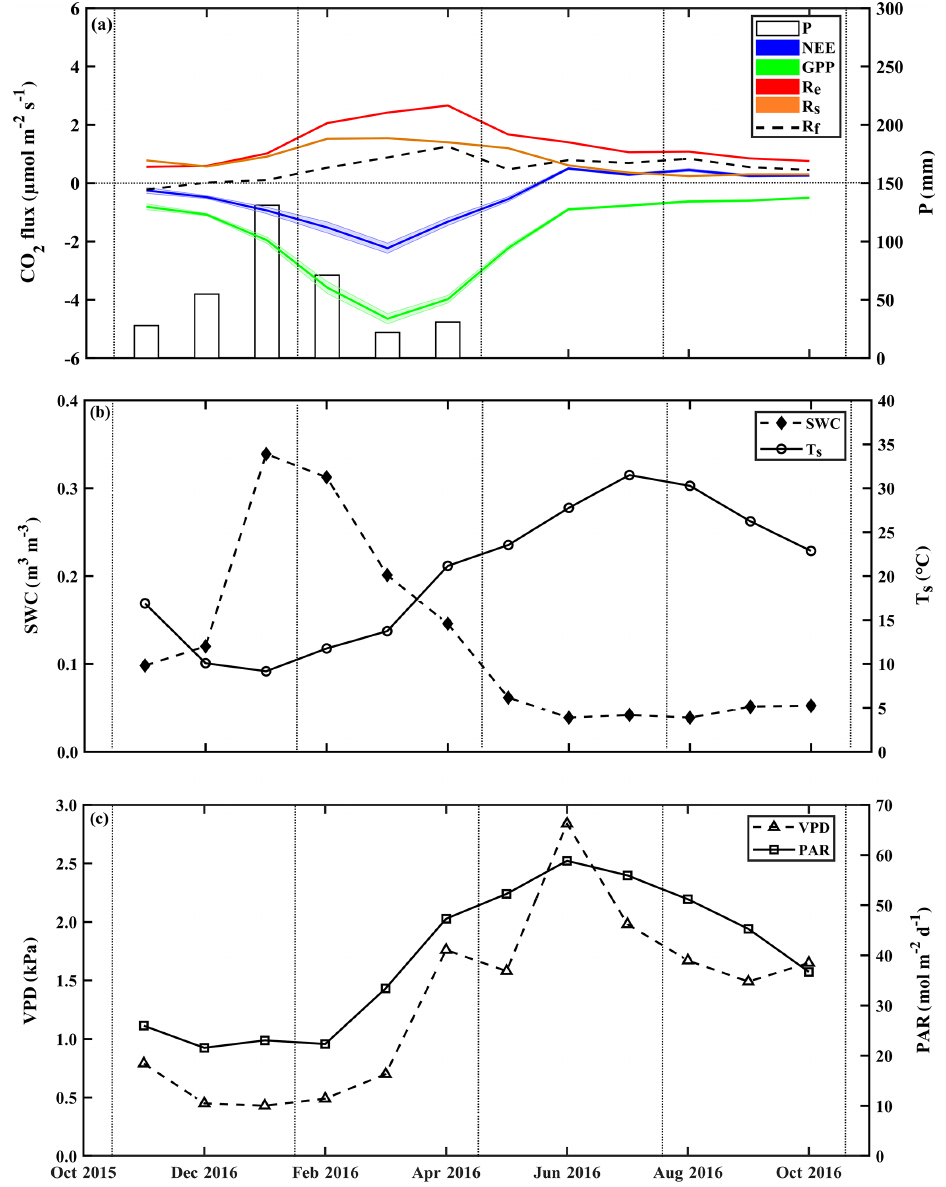
Figure 2. Seasonal trends of monthly mean values during the research period of (a) the fluxes of net ecosystem exchange (NEE), gross pri- mary production (GPP), and ecosystem respiration ( R e ) and its components, soil respiration ( R s ) and aboveground tree respiration ( R f ), and monthly mean of precipitation (P), and monthly mean of key environmental parameters; (b) soil water content at the top 10cm (SWC 0 − 10 ) and soil temperature at 5cm ( T s ); and (c) vapor pressure deficit (VPD) and photosynthetic activity radiation (PAR). R f is obtained from R e - R s . Vertical dotted lines indicate the winter, spring, summer, and fall